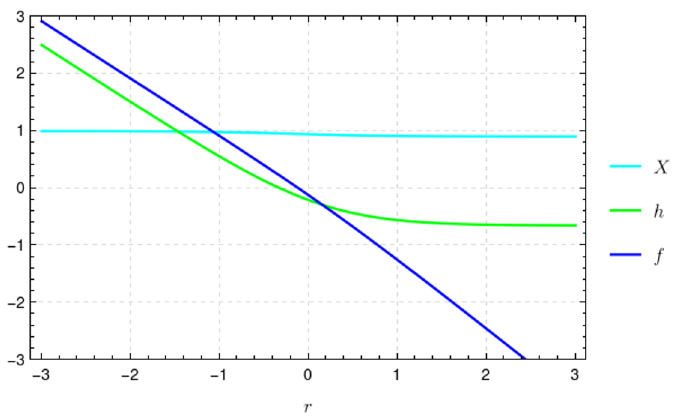
Figure 1 . Numerical interpolation between the AdS 6 and AdS 4 fixed point. The details of the numerical analysis are explained in appendix B.1. We do not plot g ( r ) since it is given by g ( r ) = − f ( r ) + log X ( r )